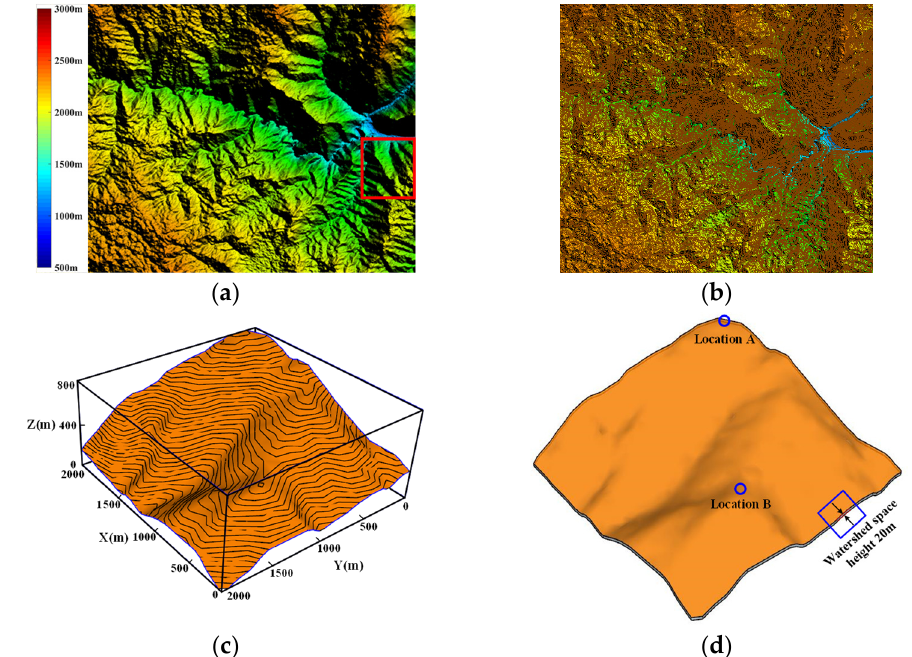
Figure 1. Terrain extraction: ( a ) Terrain elevation data; ( b ) Contour lines; ( c ) Extracted terrain surface; ( d ) Computational domain.